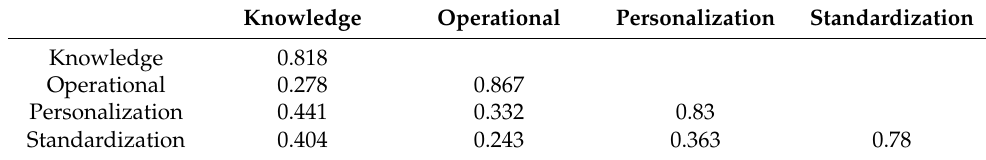
Table 9. HTMT results.